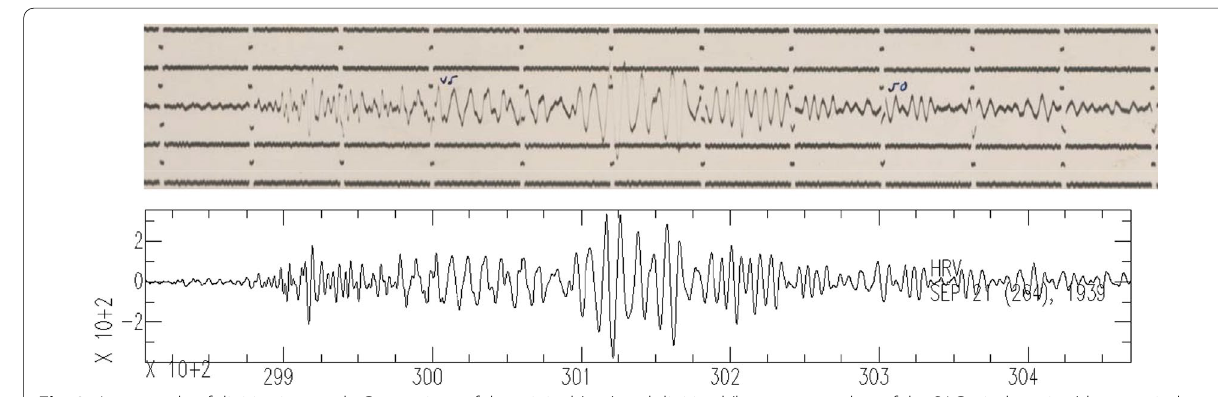
Fig. 2 An example of digitization result. Comparison of the original (top) and digitized (bottom, snapshot of the SAC window view) long-period north–south seismogram containing seismic wave arrivals. Note that the x- and y-axes do not quite match for the two plots, although the SAC display has been stretched/shrunk to mimic the original image. The numbers “45” and “50” on the original image correspond to 21:45 and 21:50 on September 21, 1939. The seismic wave arrivals are associated with a magnitude 5.8 earthquake in the Gulf of California (International Seismological Centre